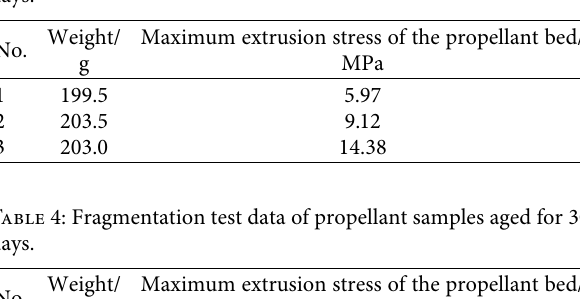
Table 3: Fragmentation test data of propellant samples aged for 15 days.